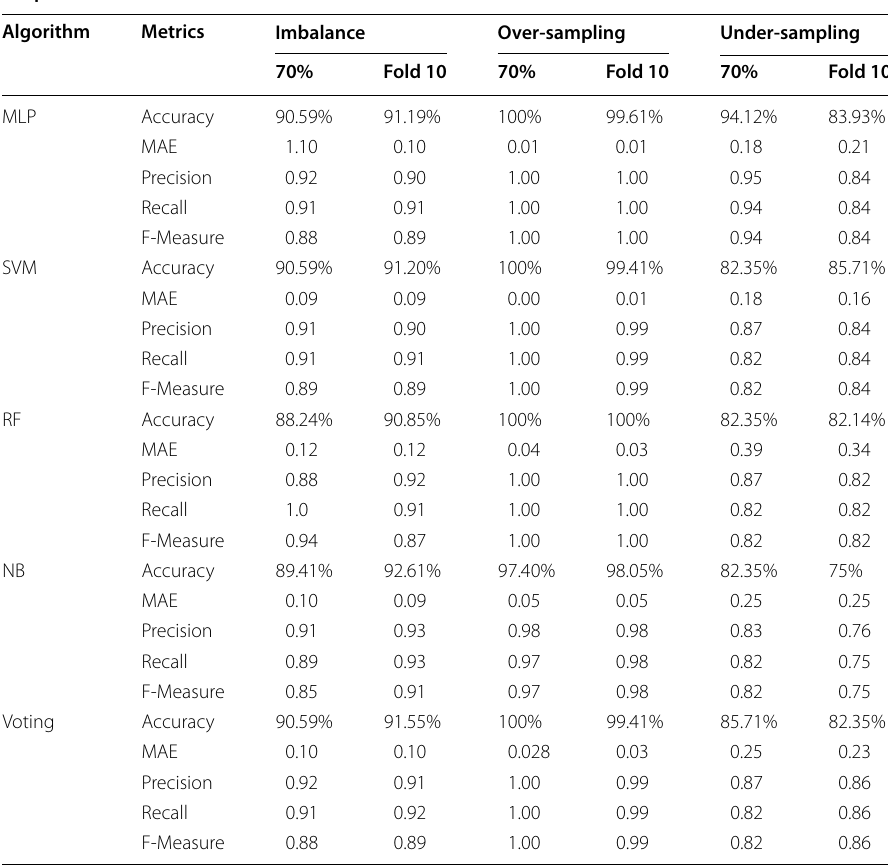
Table 11 Result of Snapchat platform Snapchat